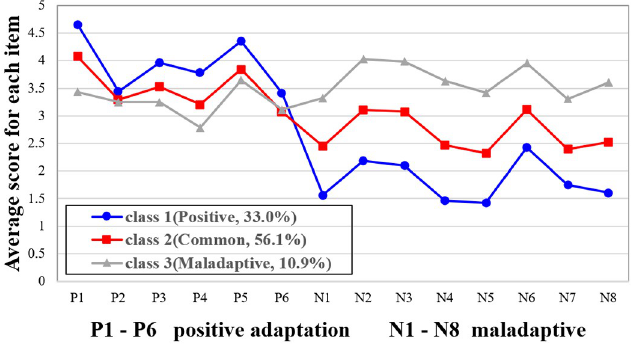
Fig 1. The specific distribution characteristics of various potential profile of college teachers’ psychological adaptation to online teaching.